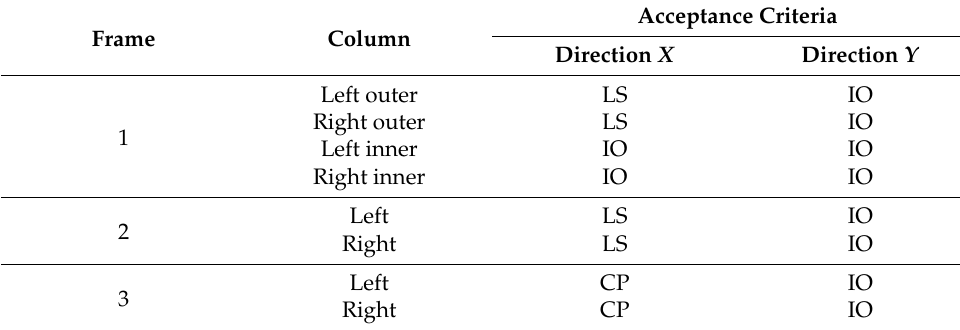
Table 8. Acceptance criteria for each column for each direction of